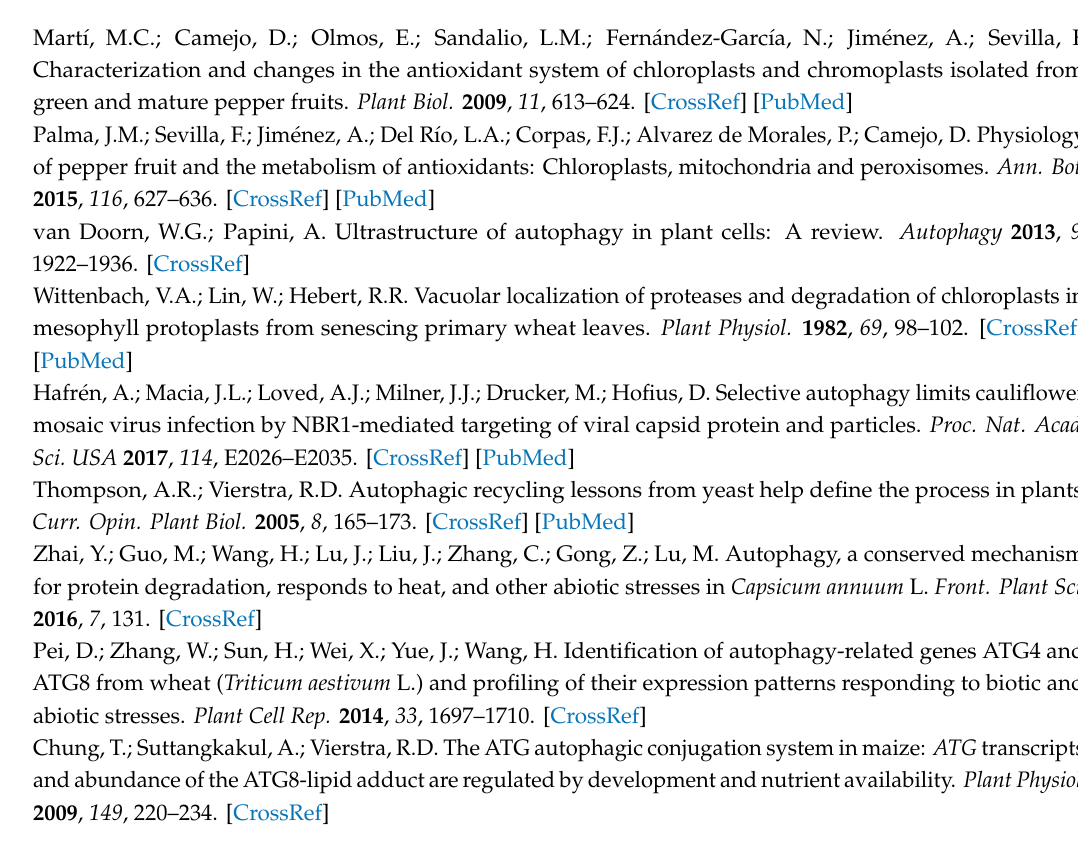
Figure S1: Transversal semi-thin sections of pericarp pepper fruits. Green pepper var. Galena (A and B). Yellow pepper var. Galena (C and D). Red pepper var. Alonso (E and F). Asterisks indicate the areas studied under the TEM. Scale bars A, C, and E = 100 µ m and B, D, and F = 50 µ m. Table S1: Sequences of primers used in the RTqPCR